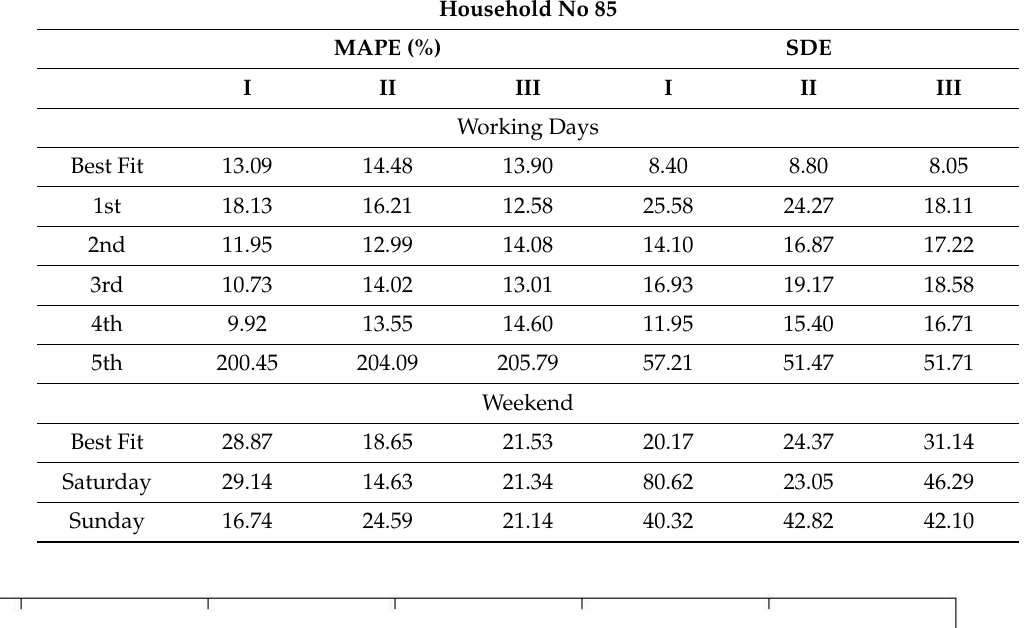
Table 6. Forecasting error values of the outputs.